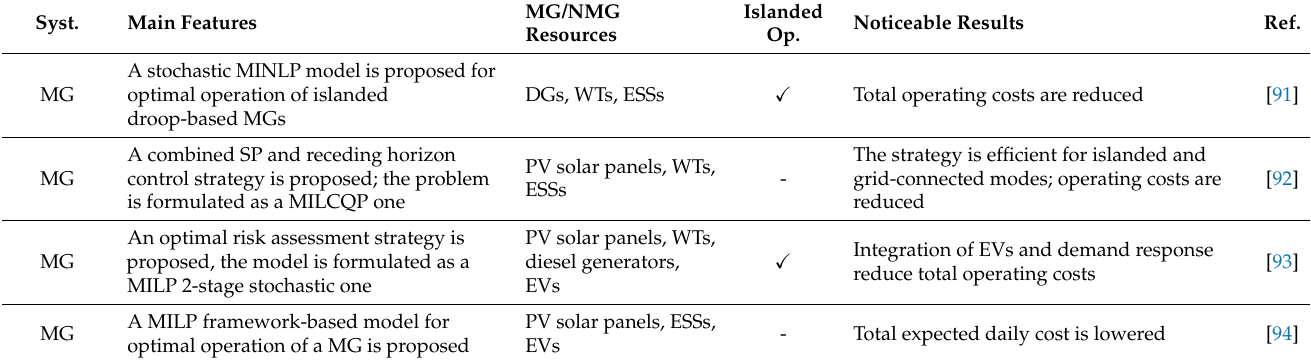
Table 6. A focus on papers dealing with stochastic programming (SP) for MG/NMG management. APPM-RE stands for aggregate production planning model with onsite renewable energy. DG stands for distributed generator. ESS stands for energy storage system. MILCQP stands for mixed integer linear constrained quadratic programming. MILP stands for mixed-integer linear programming. MINLP stands for mixed-integer nonlinear programming. MG stands for microgrid. NMG stands for networked microgrid. PTEM stands for production task and energy management. WT stands for wind